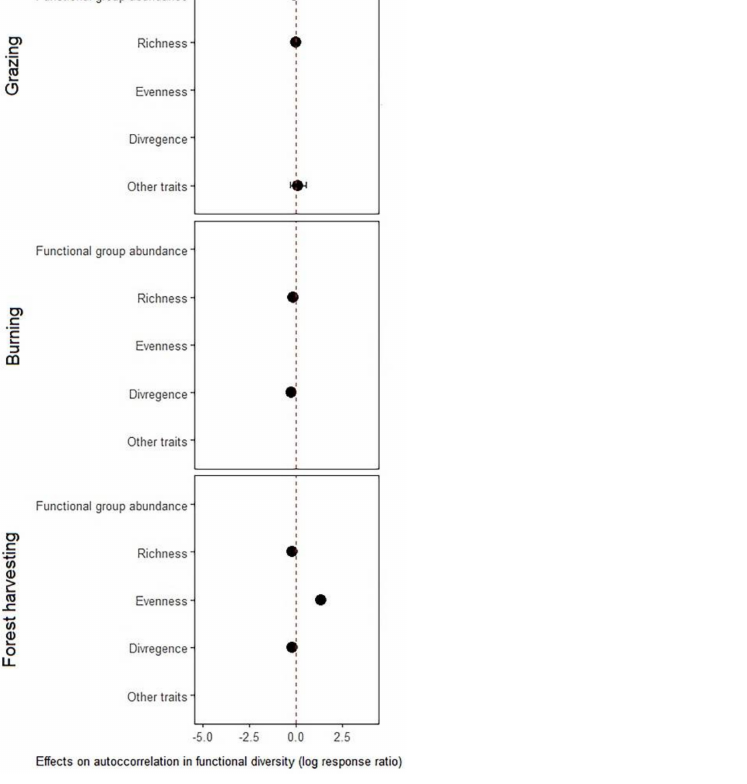
Figure A2. Disturbance effects on overall spatial autocorrelation in different indices of functional diversity for different types of disturbance. Shown in the figure is mean (solid point) and 95% confidence intervals (solid line) associated with the mean. Absence of confidence intervals indicates a single study/record (i.e., knowledge gaps).